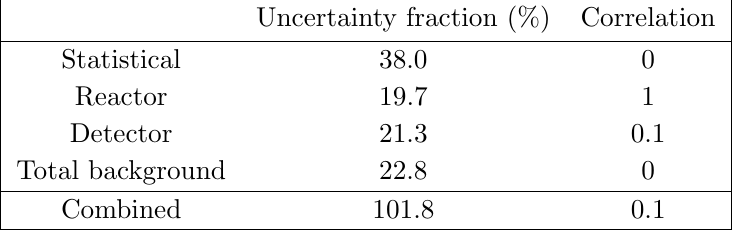
Table 7 . Fractional contribution of uncertainty source to the combined uncertainty of sin 2 2 (cid:18) 13 . The estimated correlation coe(cid:14)cients between the n-H and n-Gd uncertainties are also given. Furthermore, we obtain a ratio of sin 2 2 (cid:18) between the n-H and n-Gd 13